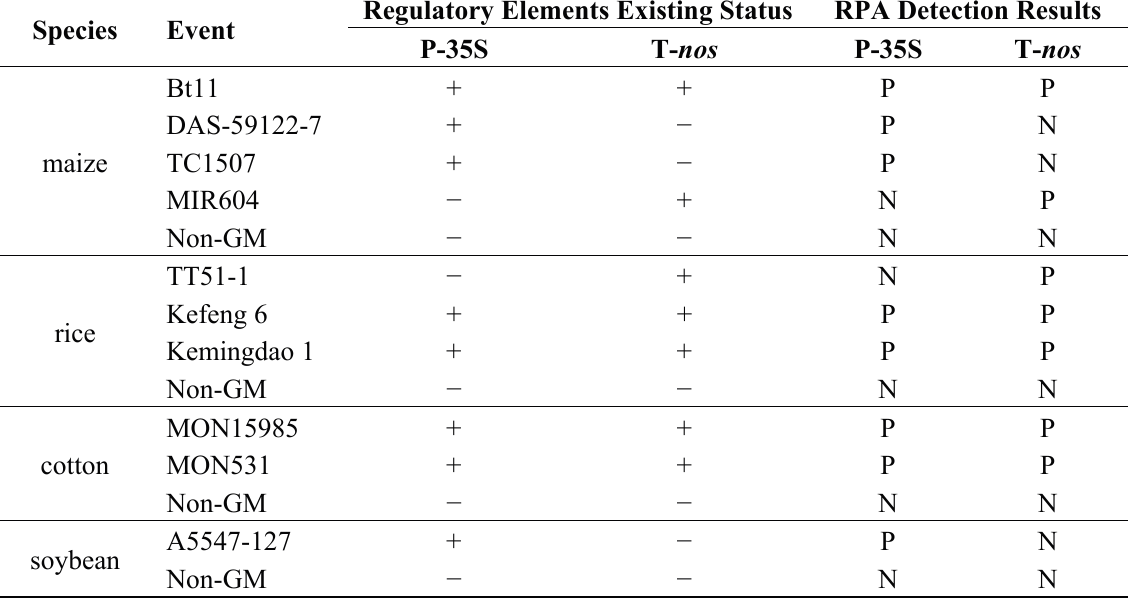
Table 4. Results of practical screening test. “+”, theoretically positive; “ − ”, theoretically negative; P, positive, experimentally verified; N, Negative, experimentally